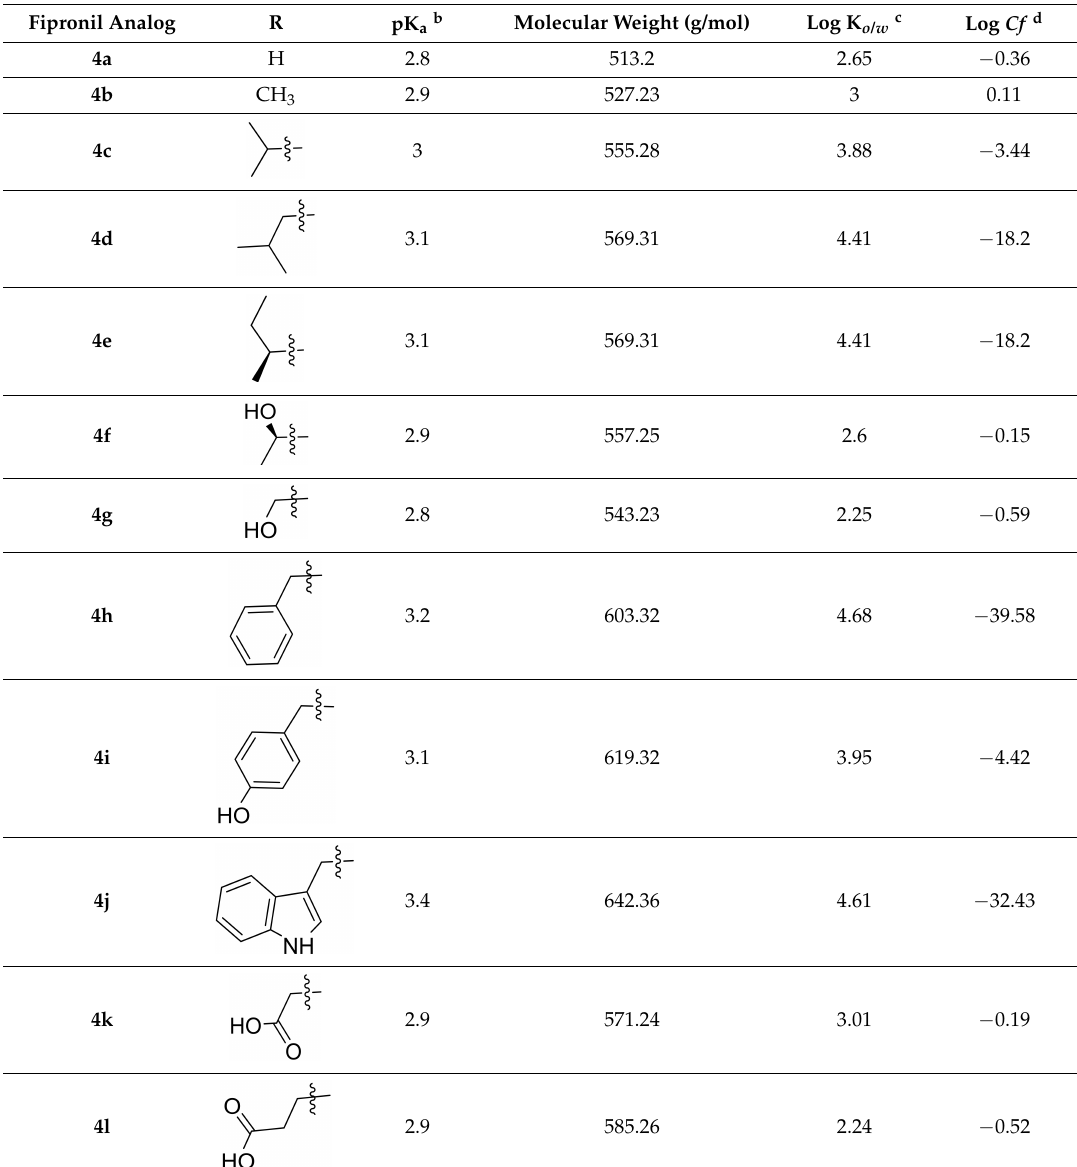
Table 2. Molecular weight, Log K o/w , and Log Cf of compounds 4a – l . a